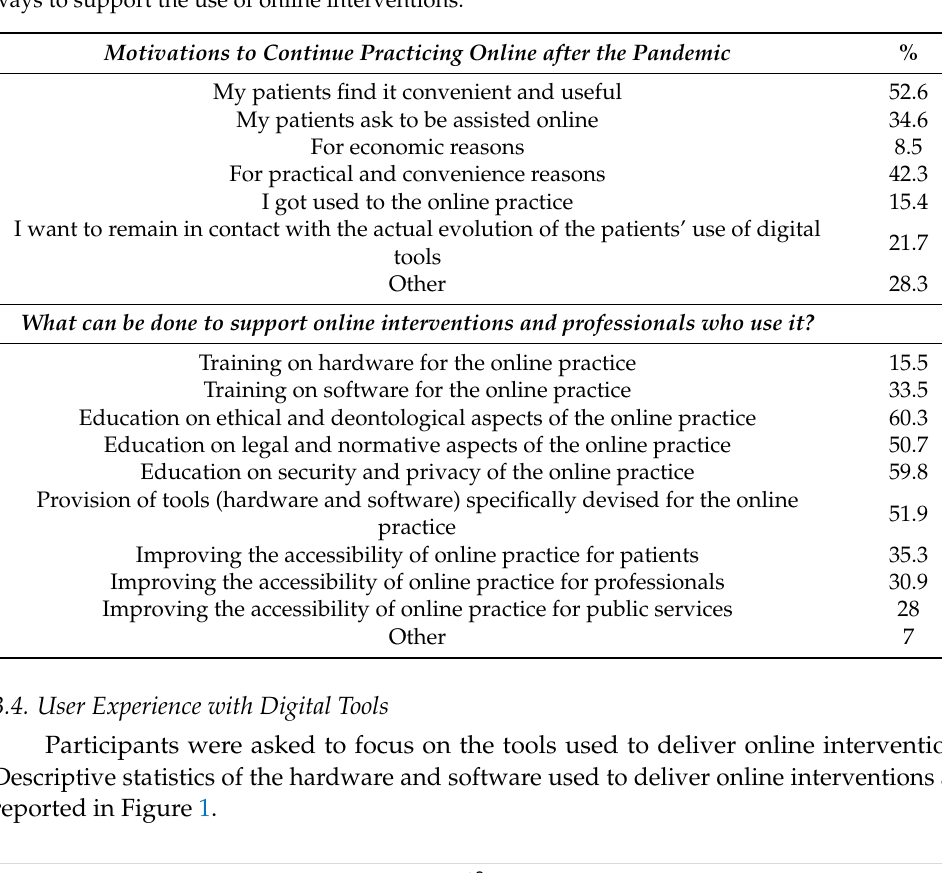
Table 7. Professionals’ motivations to continue their practice online and points of view regarding ways to support the use of online interventions.